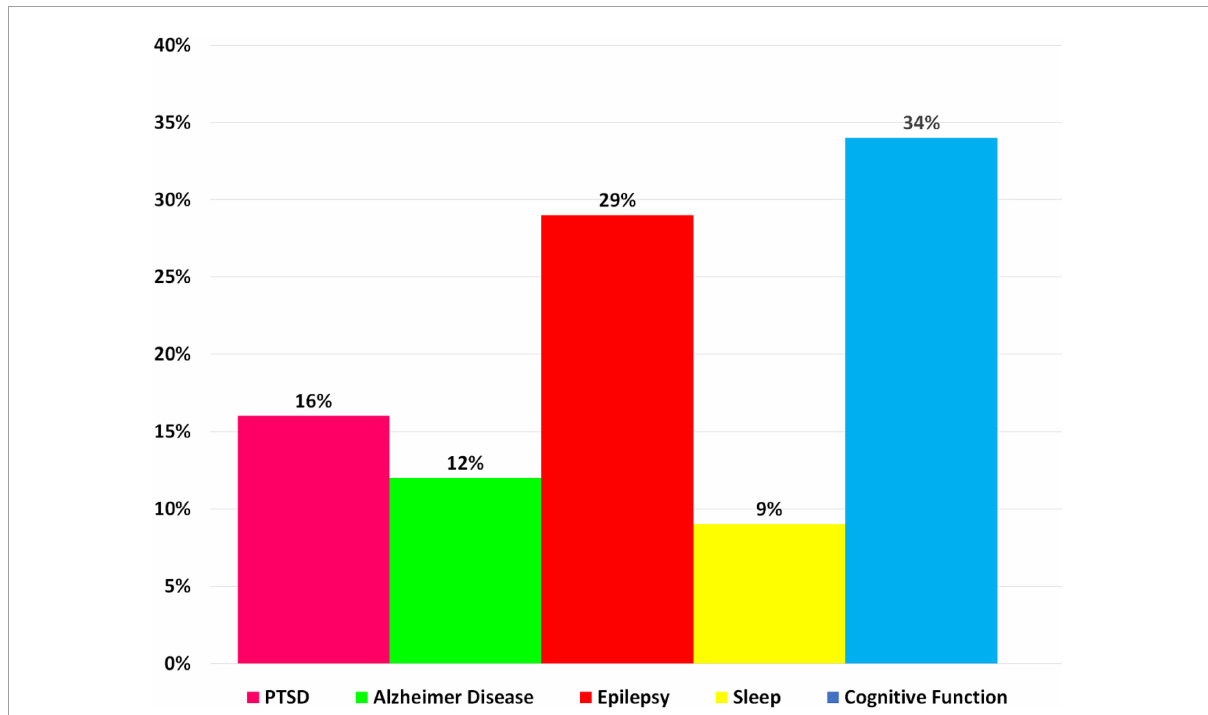
FIGURE7 A bar chart illustrating the proportion of simultaneous EEG-fMRI studies in relation to neuropsychological impairments compared with each other in a way that shows the contribution of each neurological disorder in EEG-fMRI studies.